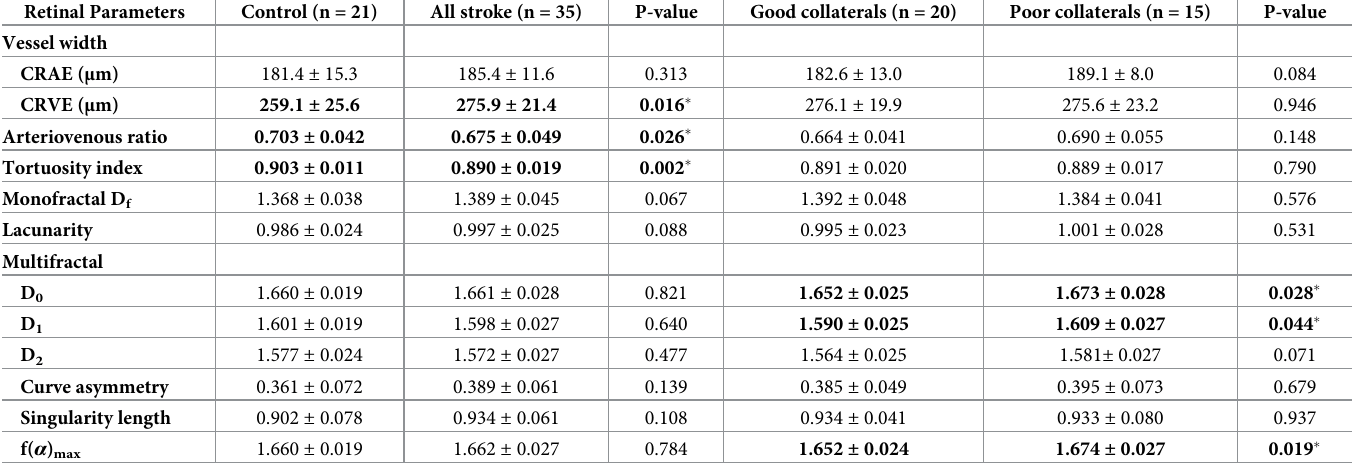
Table 2. Retinal vessel metrics comparing controls to patients with acute ischemic stroke and between patients with good and poor collaterals expressed as mean ± SD.